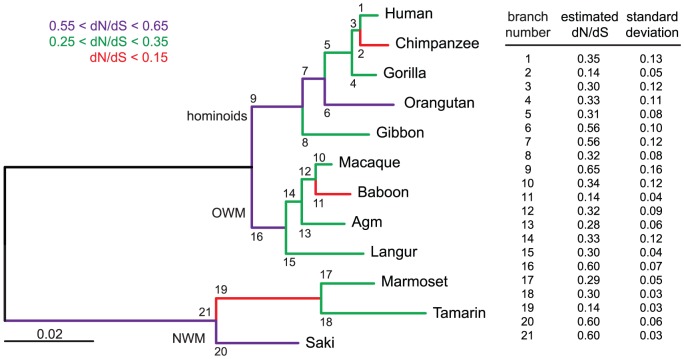
Branch-specific analysis of selection along the envV2-based phylogenetic tree.Analysis was performed using the GA-branch method from the HyPhy Package on the webserver www.datamonkey.org, and the selected model was the one with the best Akaike Information Criterion (AIC). Branch-specific analysis allows the non-synonymous to synonymous mutation ratio (dN/dS) to vary between phylogenetic branches. Such an analysis on the envV2 gene reveals that all the branches are under strong purifying selection (dN/dS<1) with no significant difference in the strength of selection between New World monkeys (NWM), Old World monkeys (OWM) and hominoids. Left: maximum likelihood tree of envV2 (same as in Figure 8) is represented together with the branch numbers. The color code for each branch class is indicated on top. Right: estimated branch-specific dN/dS values are indicated ± standard deviation.